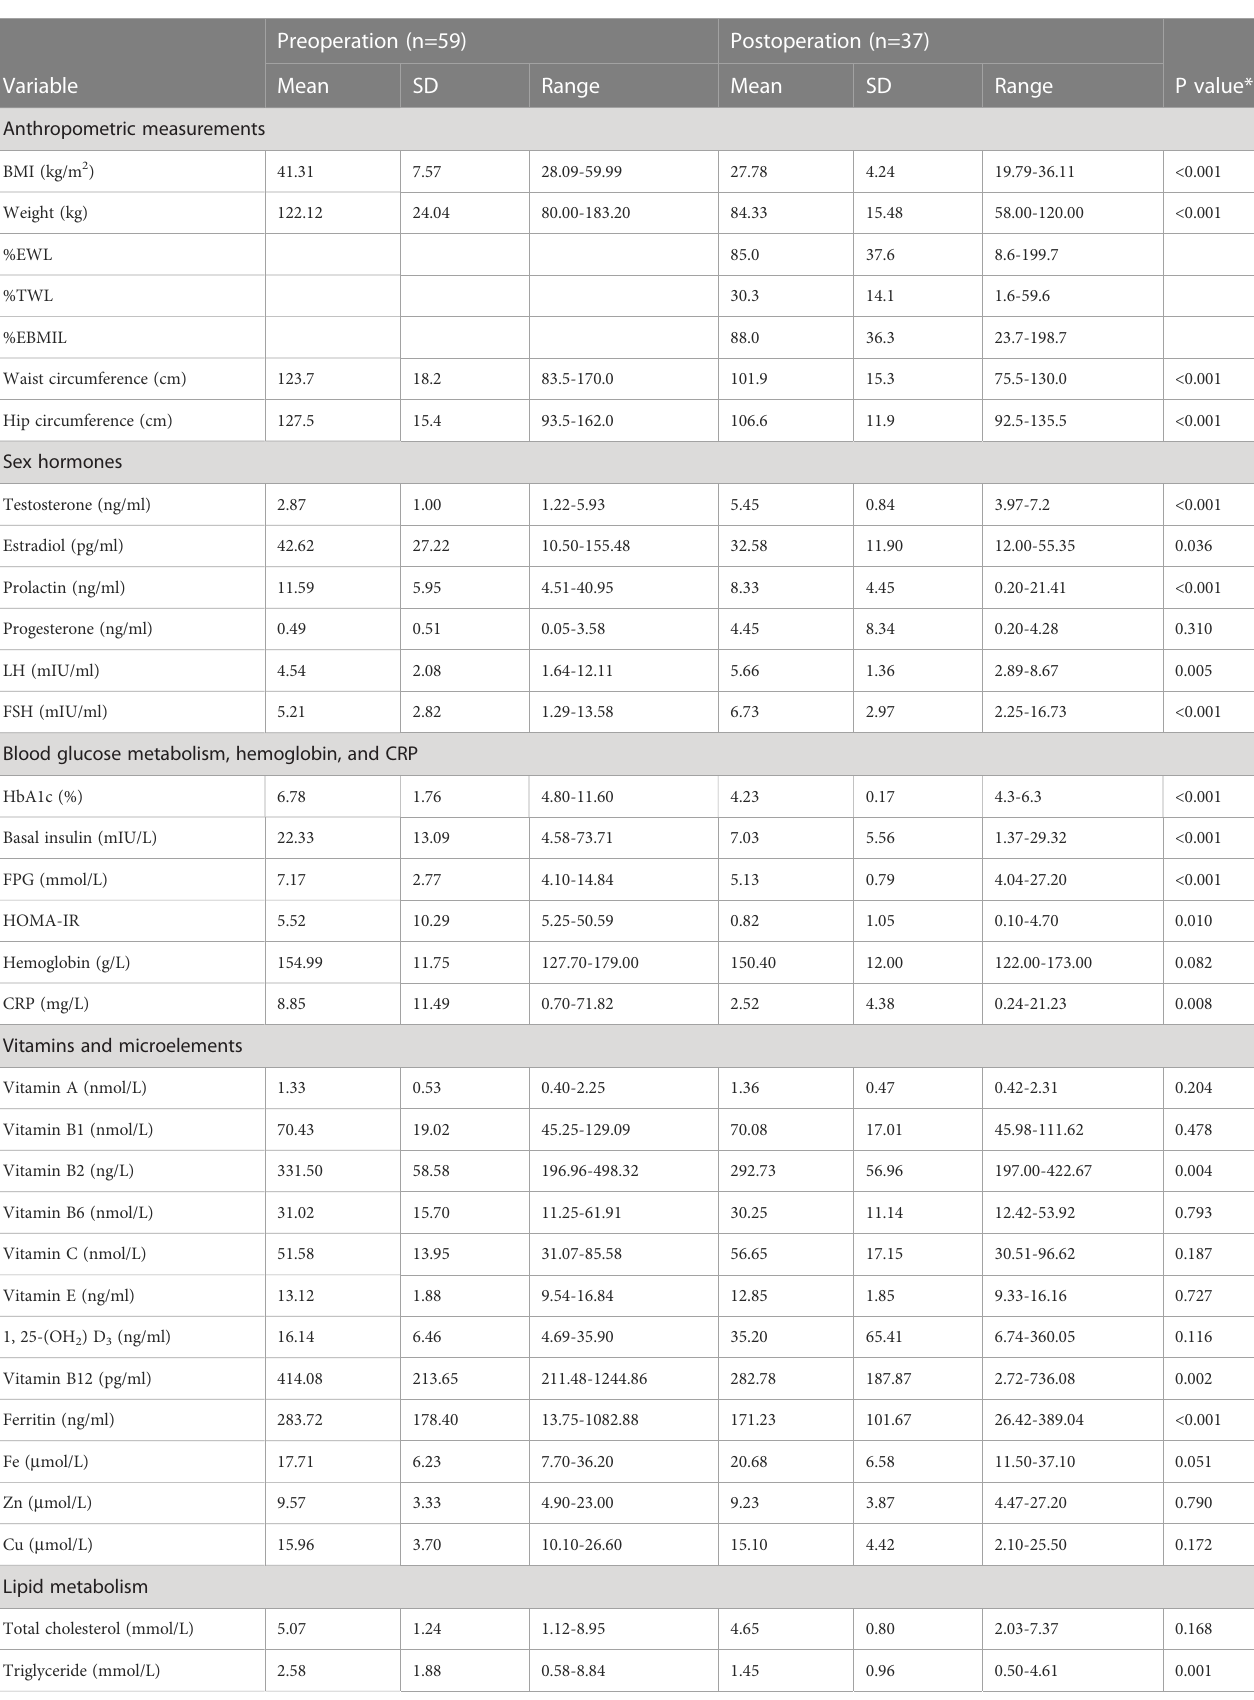
TABLE 5 Changes in anthropometric and clinical variables before and after bariatric surgery.